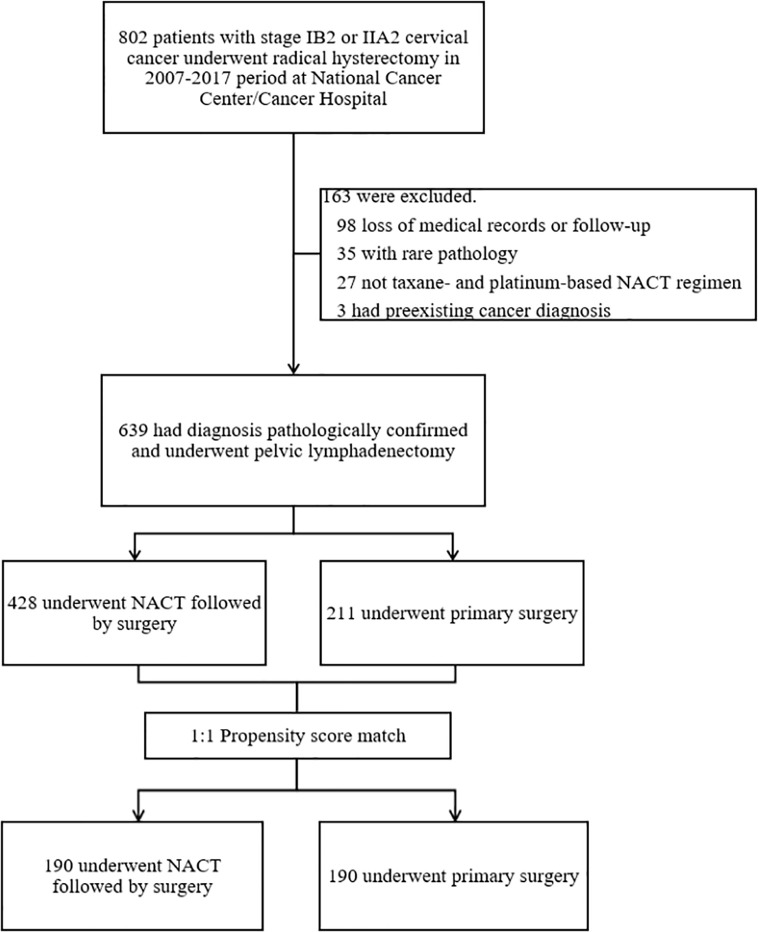
Flow chart of the patient selection process.